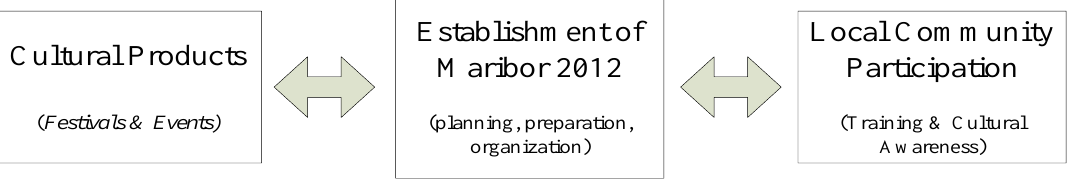
Figure 2 Maribor key steps to achieve tourism sustainability (Adapted by the